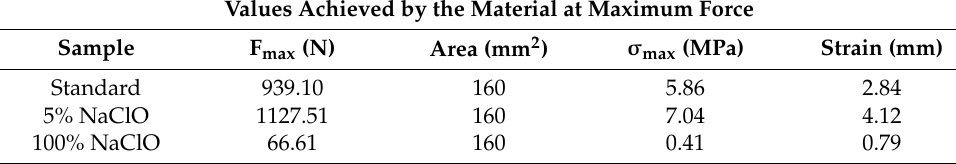
Table 6. Values achieved by beech at maximum force during tensile testing of the standard sample and samples immersed for three weeks in 5% and 100% NaClO.